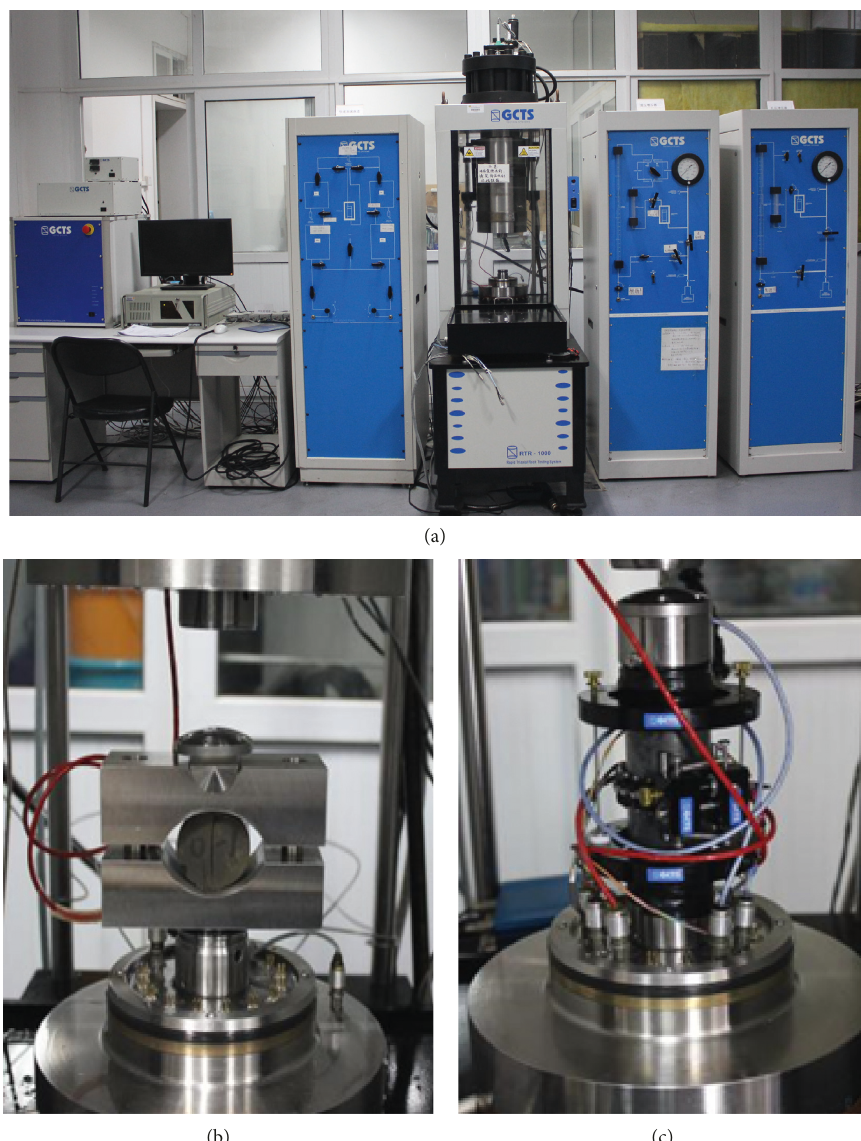
Figure 2: Compression and tensile experiments of sandstone. (a) GCTS servohydraulic machine. (b) Brazilian splitting test. (c) Uniaxial compression